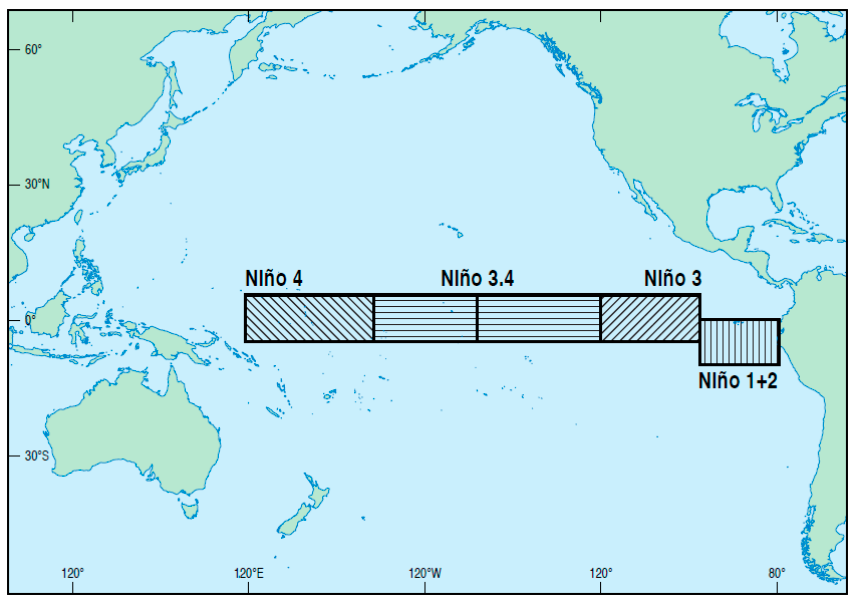
Figure 5. Niño sea surface temperature regions (see Table 2). Sourced and redrawn from Barnston [21] https://www.climate.gov/news-features/blogs/enso/why-are-there-so-many-enso-indexes-instead-just- one.